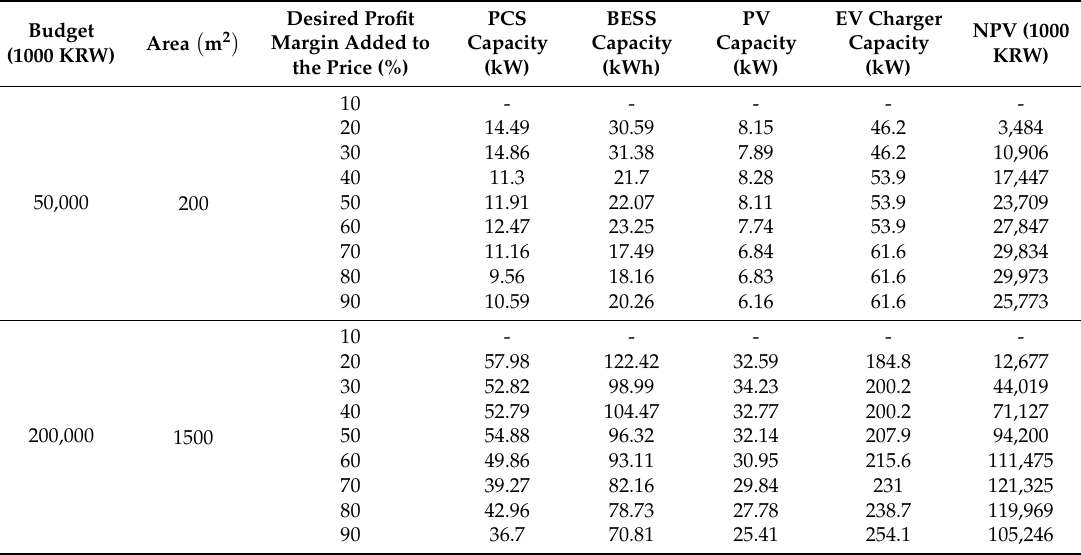
Table 8. Simulation results for Case B with base prices of